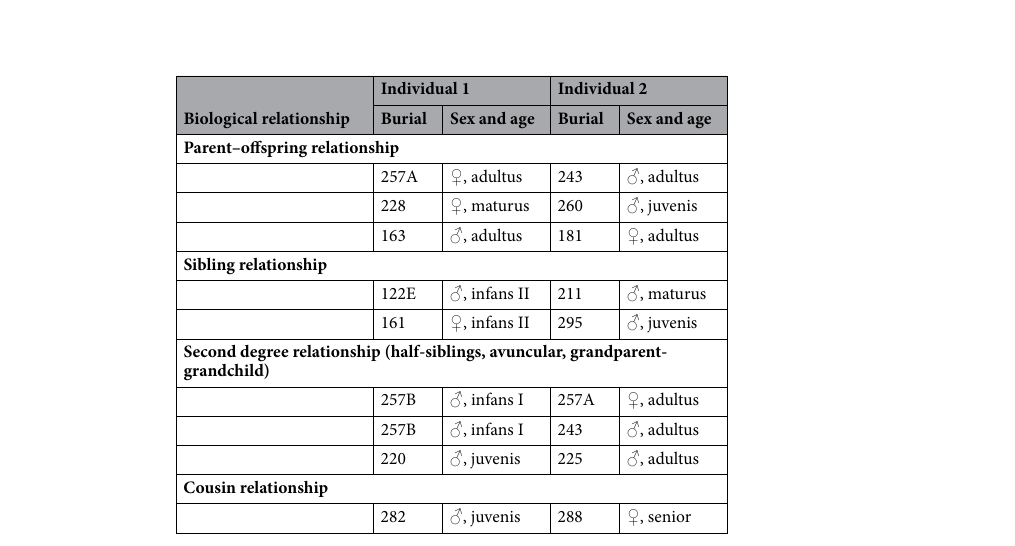
Table 2. Results of the kinship analysis obtained by lcMLkin